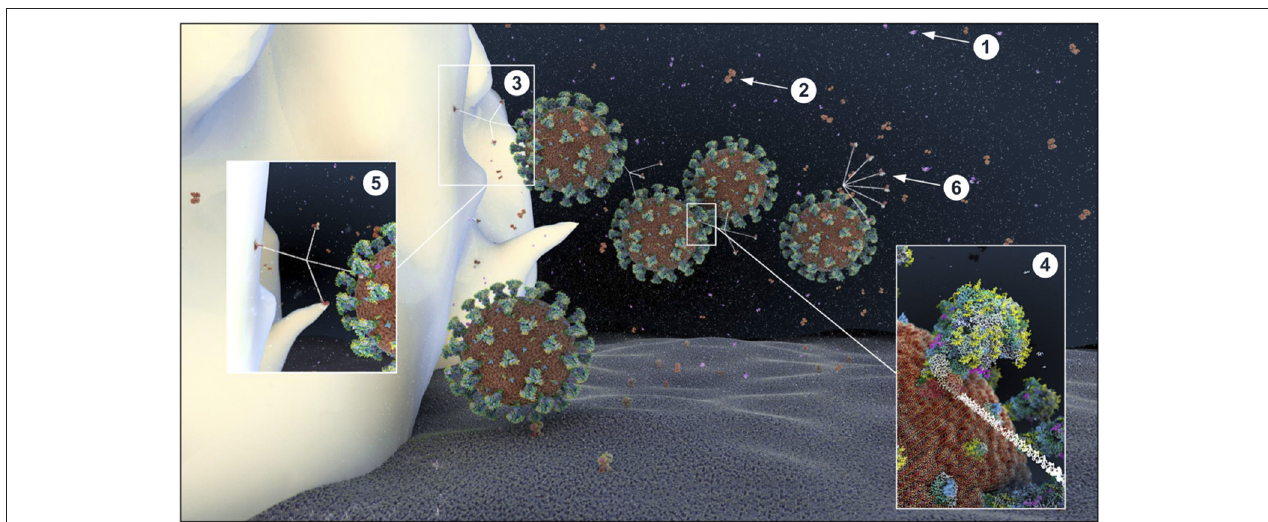
FIGURE 16 | Atomistic reconstruction of SARS-CoV-2 virions in alveolar ASL with normal glucose concentration (0.4mM). In normal conditions, SARS-CoV-2 virions entering in the lung are fought by antimicrobial factors such as β -defensin (1), lactoferrin (2) or trapped by the cruciform shape SP-D collectin (3). The CRD domain of SP-D binds to high-mannose glycans of the spikes (4), trapping viruses in a mesh for alveolar macrophage phagocytosis [(5); receptors expressed on the macrophage surface for collectin recognition is not represented here]. Some particles evade the defense system and reach the epithelial surface for ACE2 receptor binding. The fan shape of SP-A collectin (6) is probably not adapted for efficient virus recognition but may participate in apoptotic cell uptake and inflammation resolution (see section Methods for detailed ID of the components